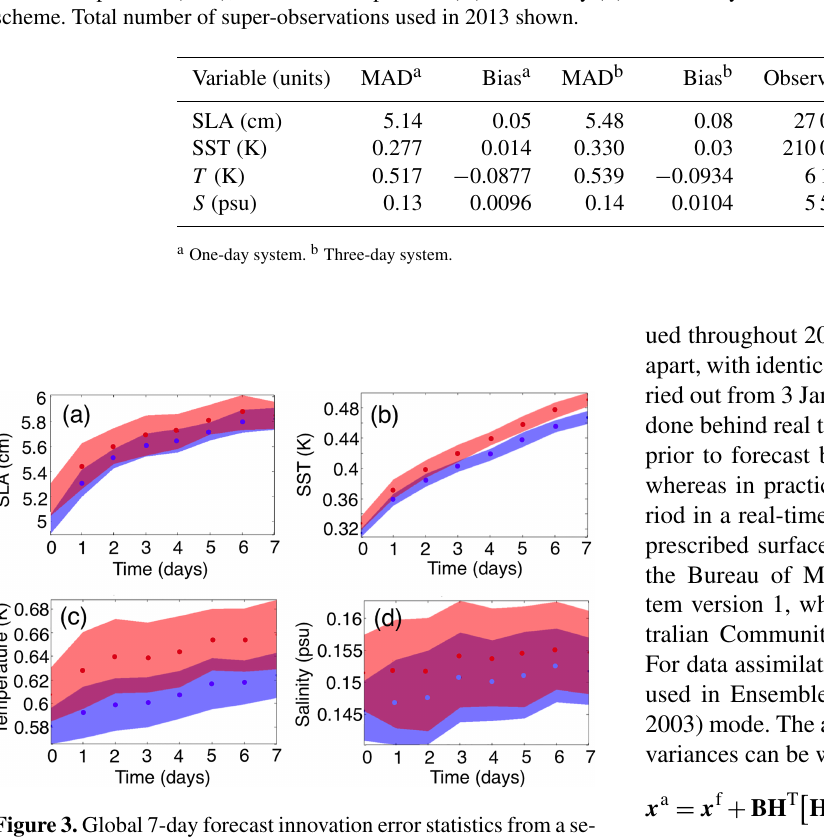
Figure 3. Global 7-day forecast innovation error statistics from a se- ries of identical base dates for (a) sea-level anomaly, (b) sea surface temperature, (c) subsurface temperature and (d) subsurface salinity. The 1-day system is shown in blue, and the 3-day is system shown in red. The envelopes represent ± 1 standard deviation in forecast error. See Fig. 2 for forecast